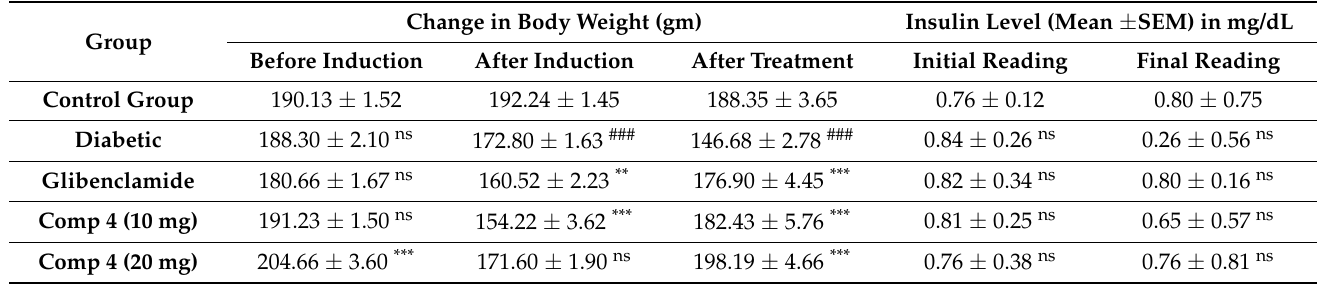
Table 3. Effect of compound 10d on body weight and insulin